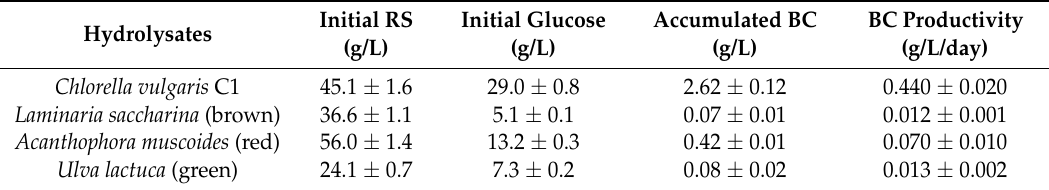
Table 4. Characteristics of the BC production by immobilized Komagataeibacter xylinum B-12429 cells in the media based on hydrolysates of biomass of micro- and macro-algae. RS, reducing sugars.